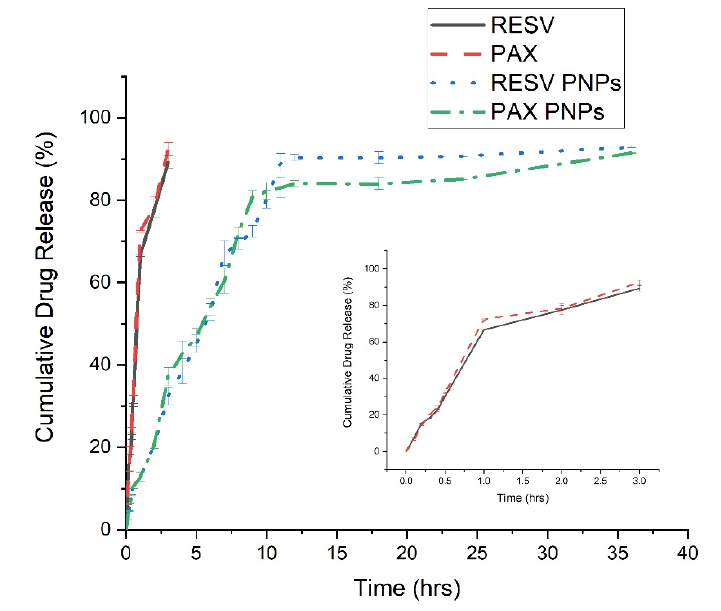
Figure 5. In vitro drug release profile of free PAX, RESV, PAX and RESV PNPs